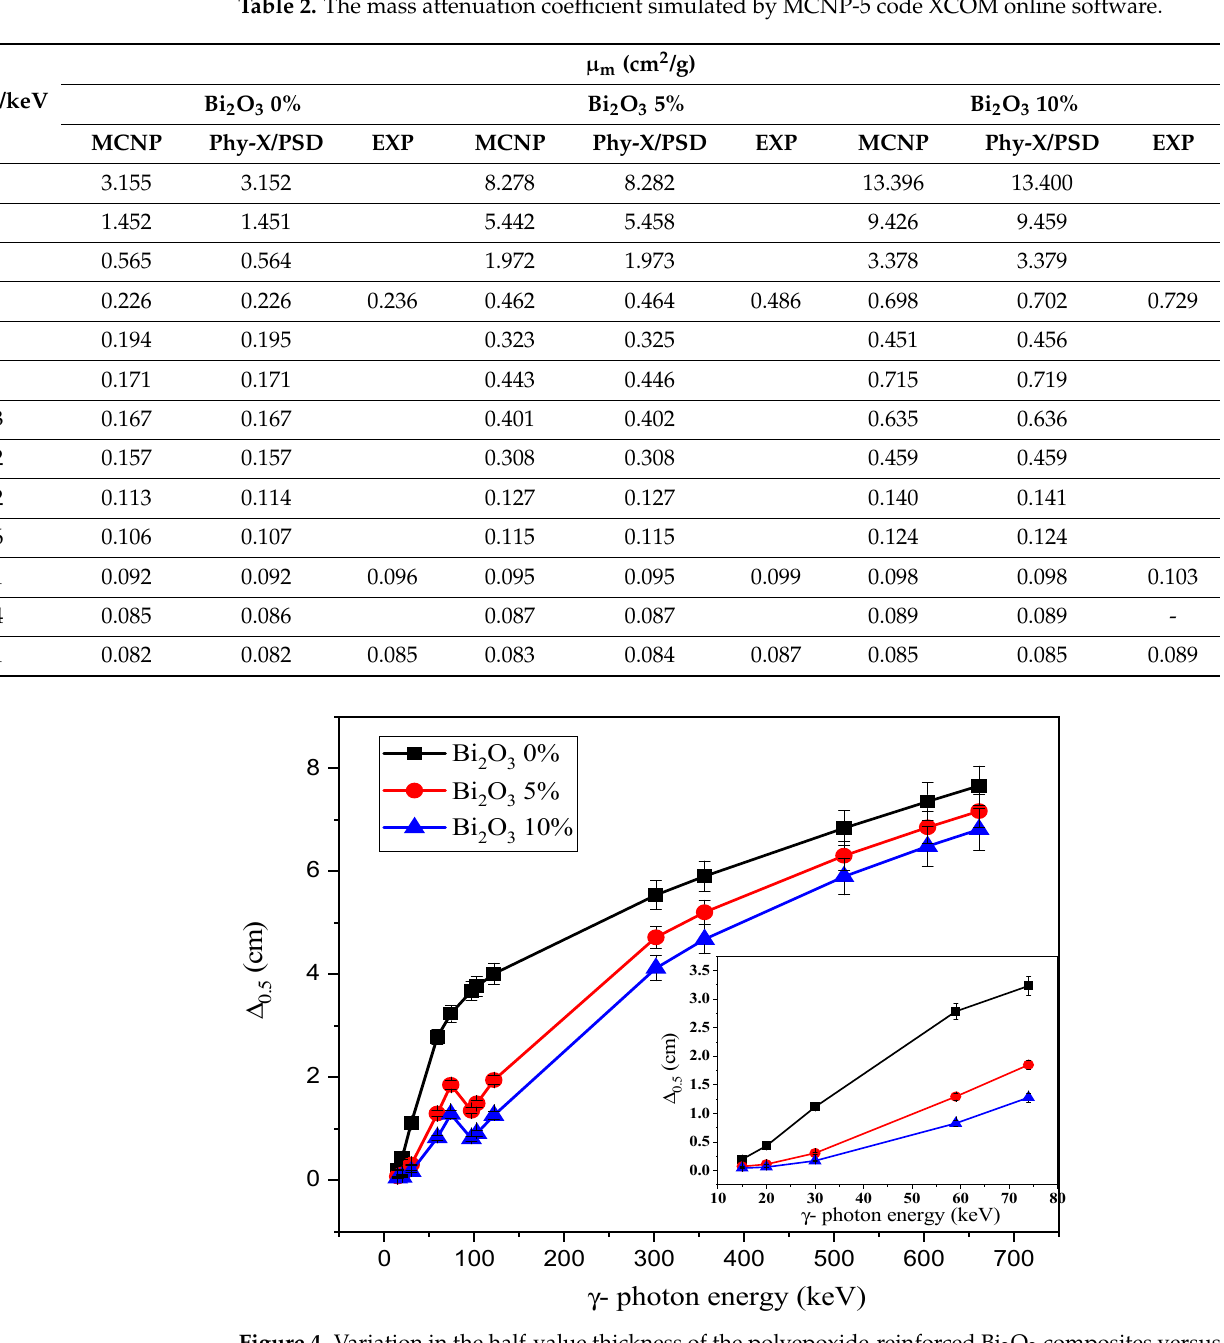
Figure 4. Variation in the half-value thickness of the polyepoxide-reinforced Bi 2 O 3 composites the γ -photon versus the γ -photon energy.